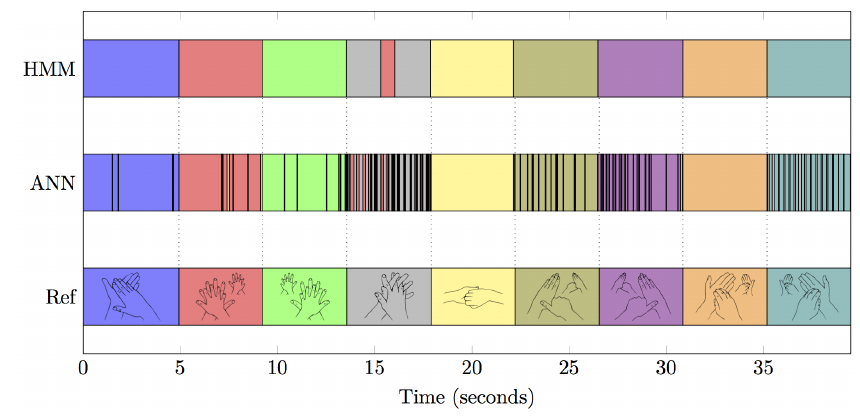
Figure 7. Comparison of the classification results of ANNs with the smoothed version after